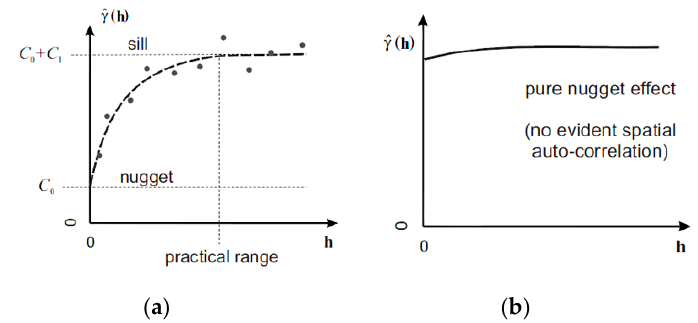
Figure 7. Variogram forms: ( a ) bounded variogram; ( b ) pure nugget (modified from [40]).